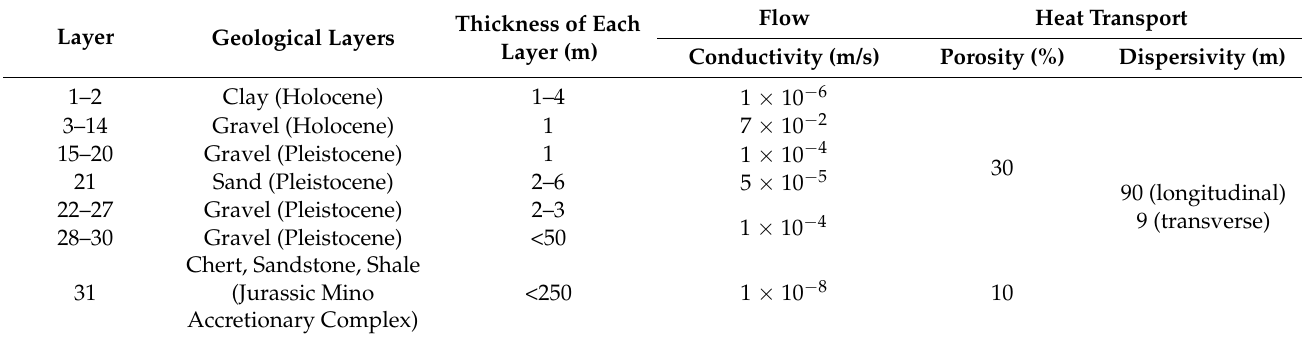
Figure 6. ( Left ) The area setting the Temperature Boundary Condition as a recharge zone, ( Right ) Temperature change of the recharge zone. Table 1. Material properties for flow and heat transport.